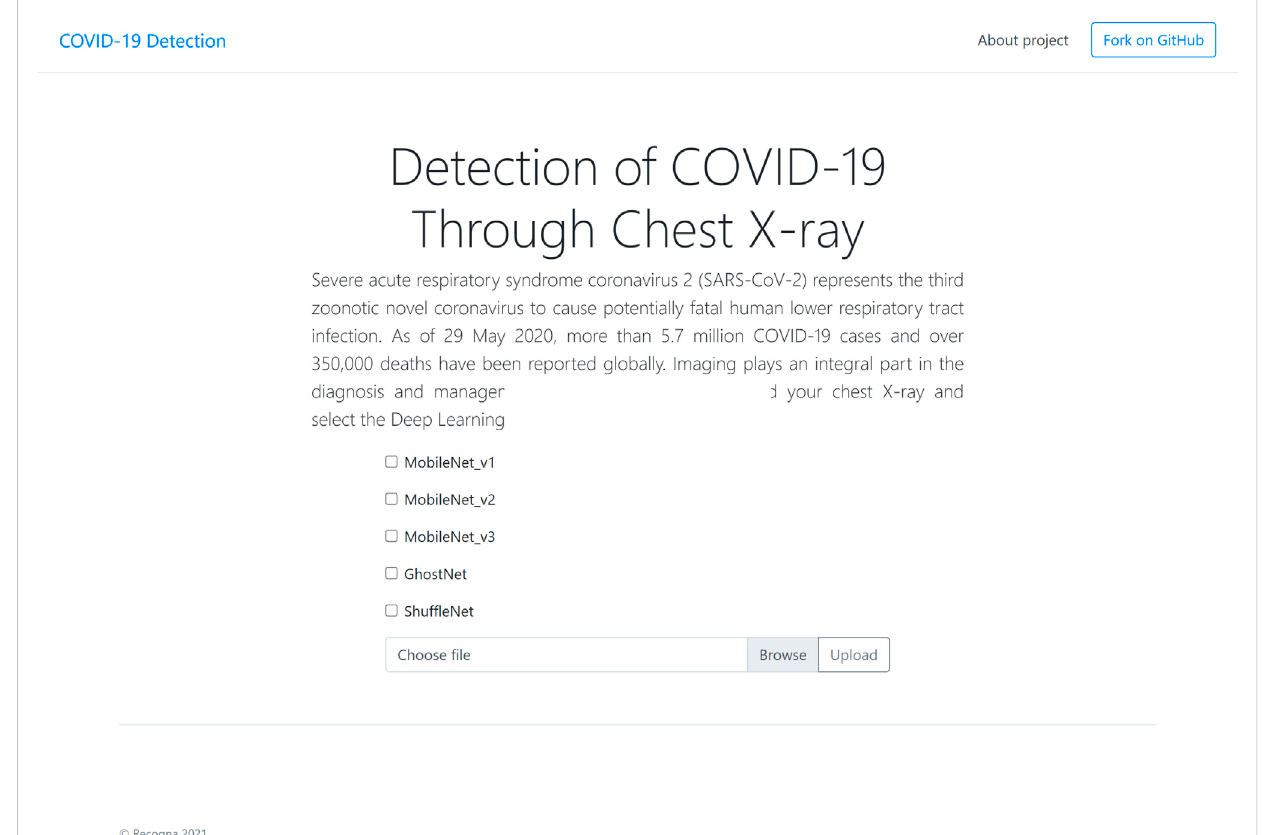
FIGURE 10 Primary screen of the web tool to identify COVID-19 from chest X-ray